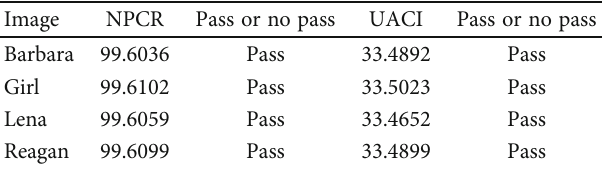
Figure 11. The initial keys are set to η = 3 : 7 , θ = 5 : 2 , λ = = 0 : 65478466897887 , and y = 0 : 85426984531656 . 2 : 6 , x 0 0 The new keys are set to η = 3 : 7 + 10 − 15 , θ = 5 : 2 + 10 − 15 , λ = 2 : 6 + 10 − 15 , x = 0 : 65478466897887 + 10 − 15 , and y = 0 0 0 : 85426984531656 + 10 − 15 .